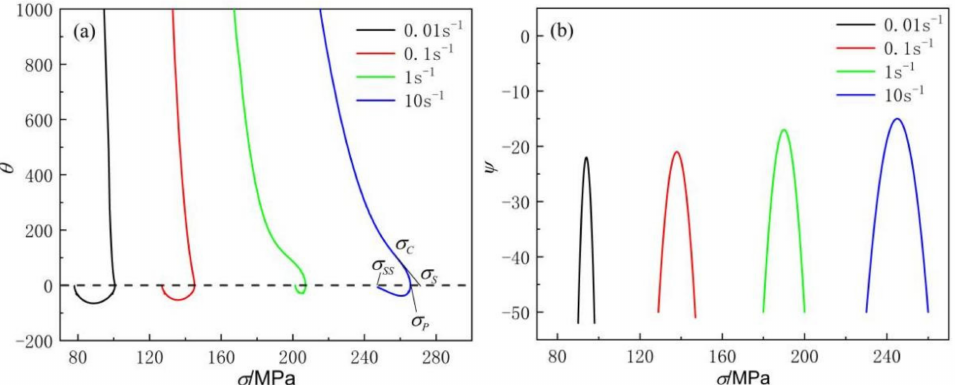
Figure 10. Relationship curves between the hardening rate and flow stress at 1050 ◦ C: ( a ) θ - σ curves; ( b ) ψ - σ